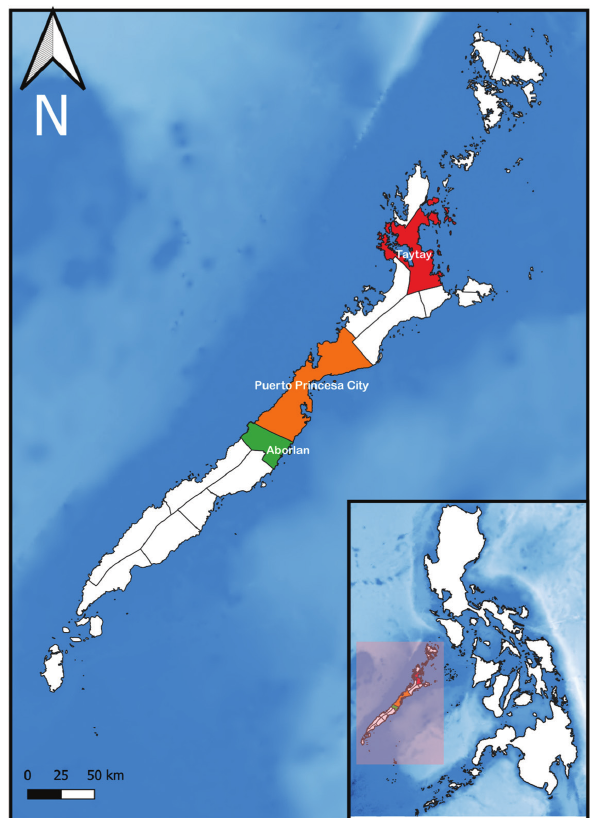
Map of Palawan showing an inset of the Philippines, with Palawan highlighted with a light red shade. Aborlan, Puerto Princesa City and Taytay are highlighted in green, orange and red colours, respectively. (Source: Authors,